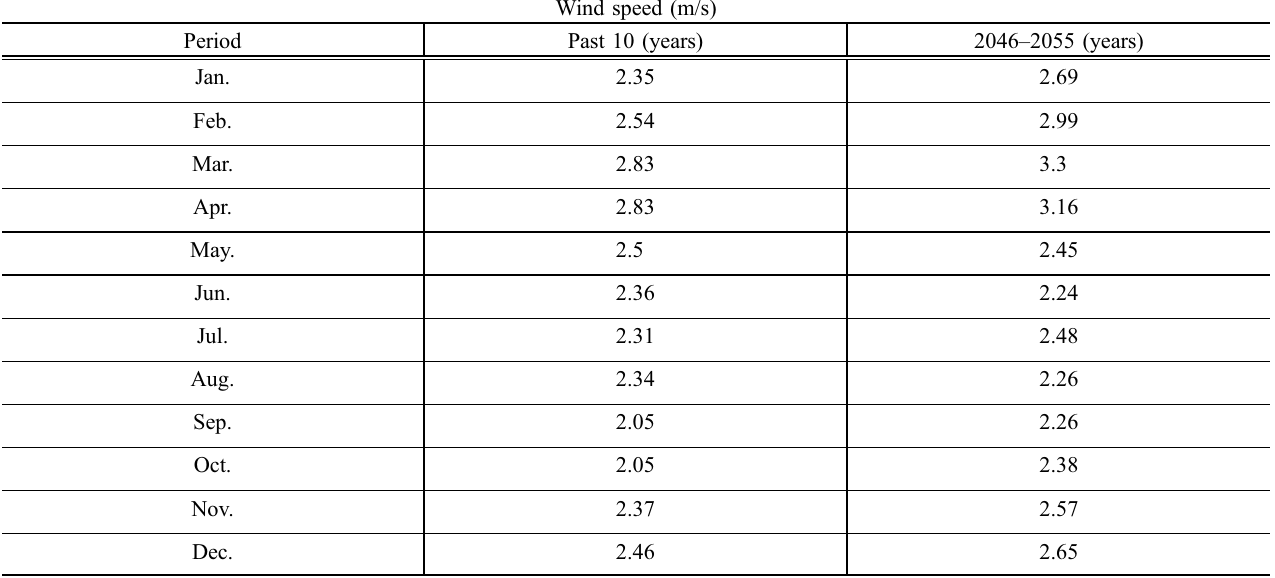
Table 8 Change in wind speed by RCP scenario.